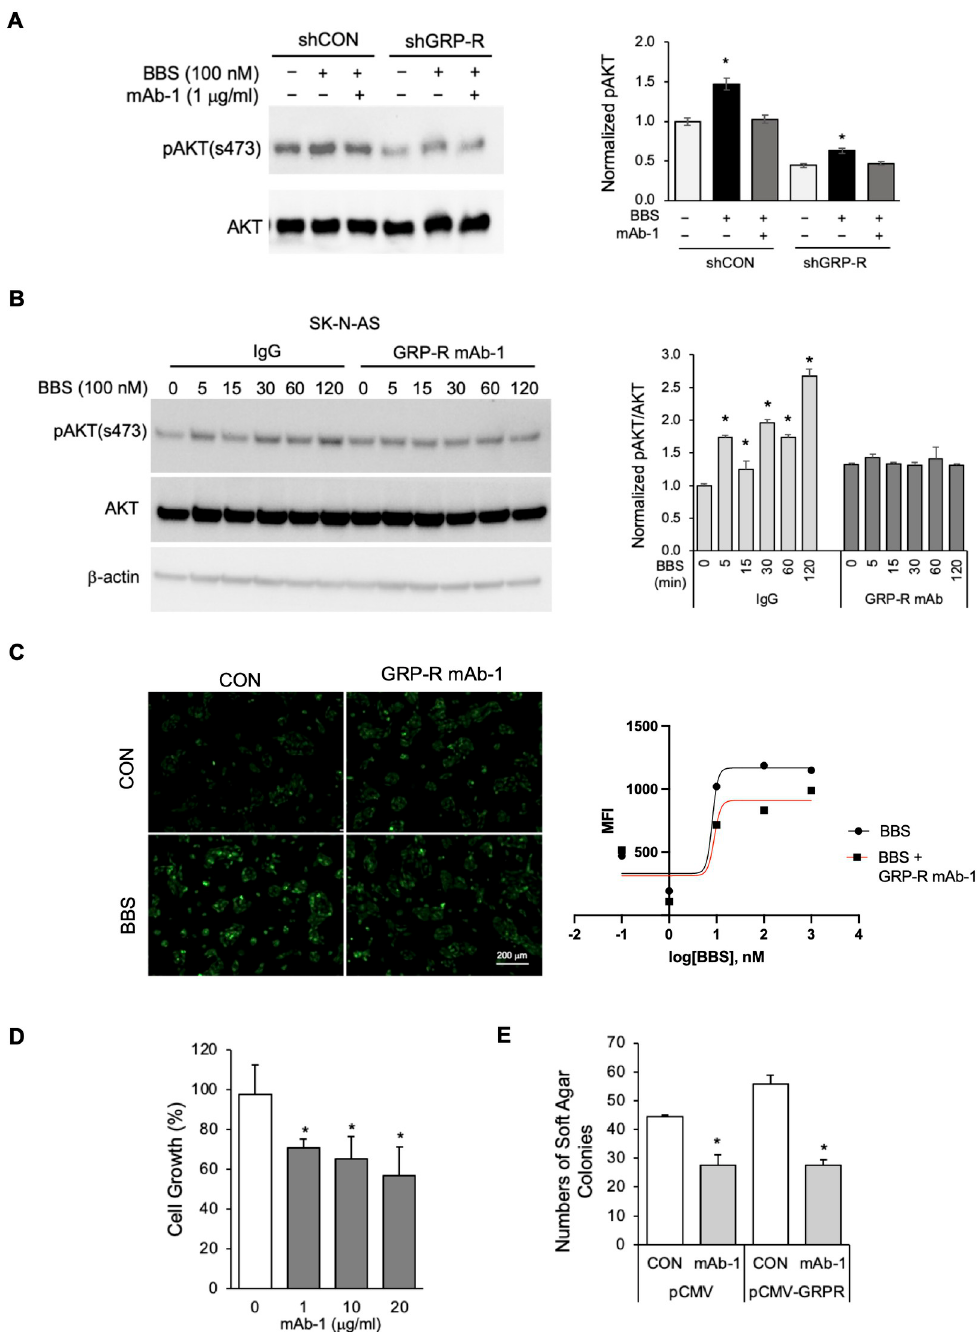
Fig 3. GRP-R mAb-1 inhibitory roles on neuroblastoma cell in vitro . (A) GRP-R mAb-1 inhibited BBS-mediated activation of AKT in BE(2)-C cells. The phosphorylation of AKT (S473) was detected by immunoblotting assay in BE(2)-C cells. The cells were pretreated with GRP-R mAb-1 at 1 mg/ml for 60 minutes, then treated with BBS at 100 nM for 15 minutes (left). The level of pAKT (s473) was normalized to total AKT with ImageJ (right). (B) GRP-R mAb-1 inhibited BBS-mediated activation of AKT in SK-N-AS cells. The phosphorylation of AKT (S473) was detected by immunoblotting assay in SK-N-AS cells. The cells were pretreated with GRP-R mAb or its isotype control IgG for 60 minutes, followed by BBS at 100 nM for 5–120 minutes (left). The level of pAKT (s473) was normalized to total AKT with ImageJ (right). (C) GRP-R mAb-1 reduced BBS-stimulated intracellular Ca 2+ release signals. SK-N-AS cells were treated with BBS at 100 nM for 30 minutes. The calcium response was subsequently analyzed with Flu-4 Direct ™ Calcium Assay Kit. The green fluorescence signal indicated the released intracellular Ca 2+ in SK-N-AS cells (left). The mean of green fluorescence